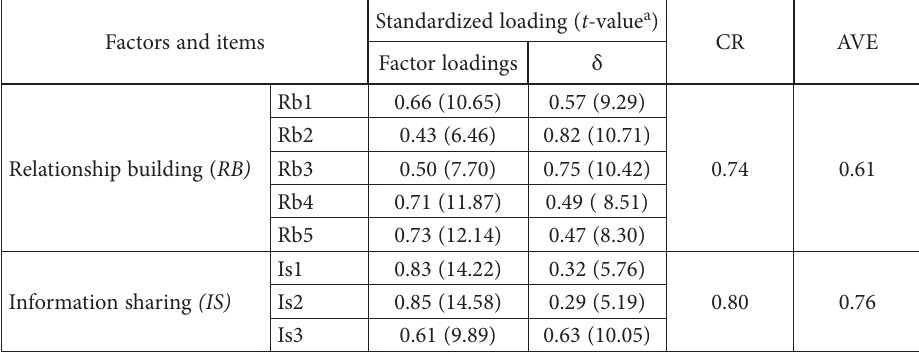
Table 3. Properties of CFA for full models, means, and standard deviations Factors and